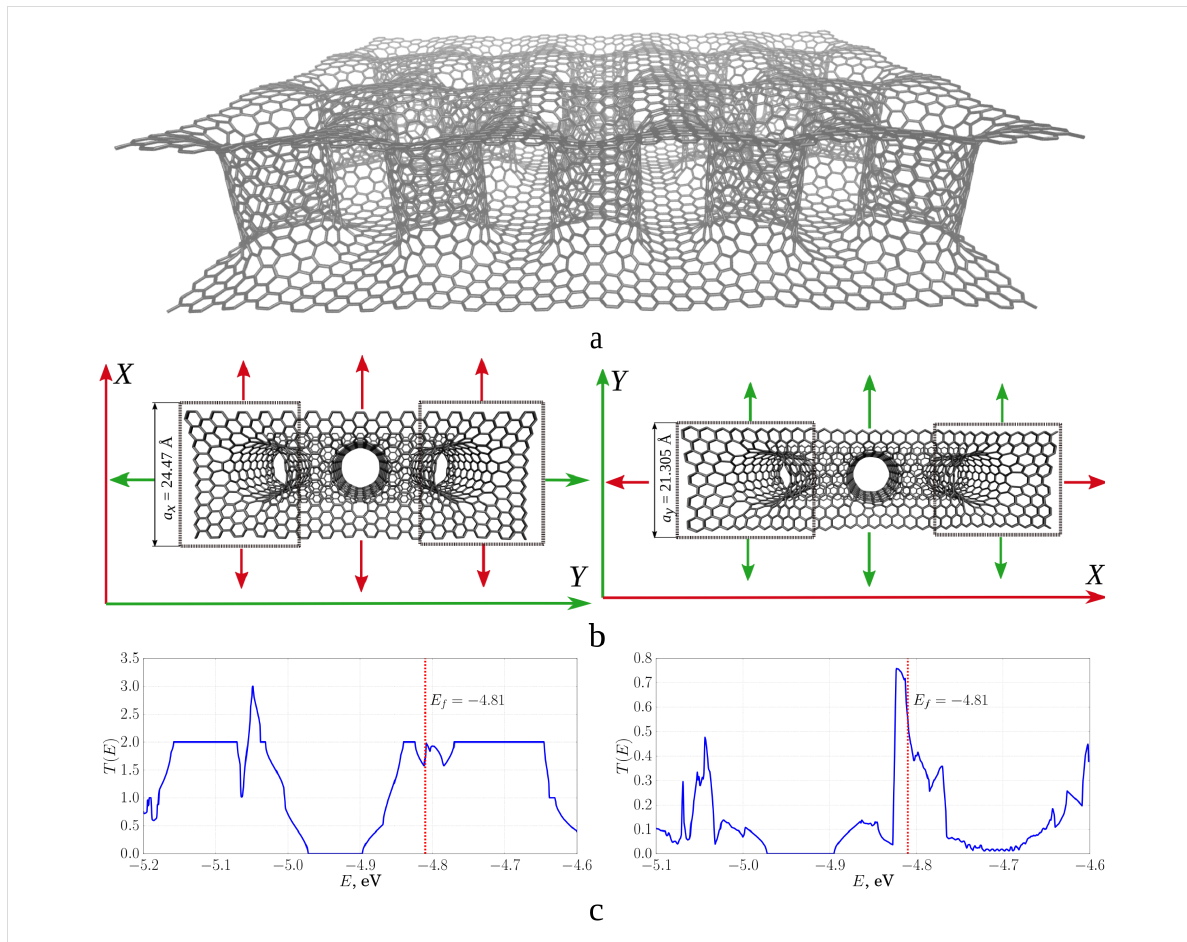
Figure 5: 2D composite of pillared graphene based on CNT (9,9) with a length of 2.4 nm: a) atomic structure; b) schematic representation of the cell of the composite and electrodes in the case of electron transport along X (left) and Y (right); c) transmission functions along the X - (left) and Y - (right)